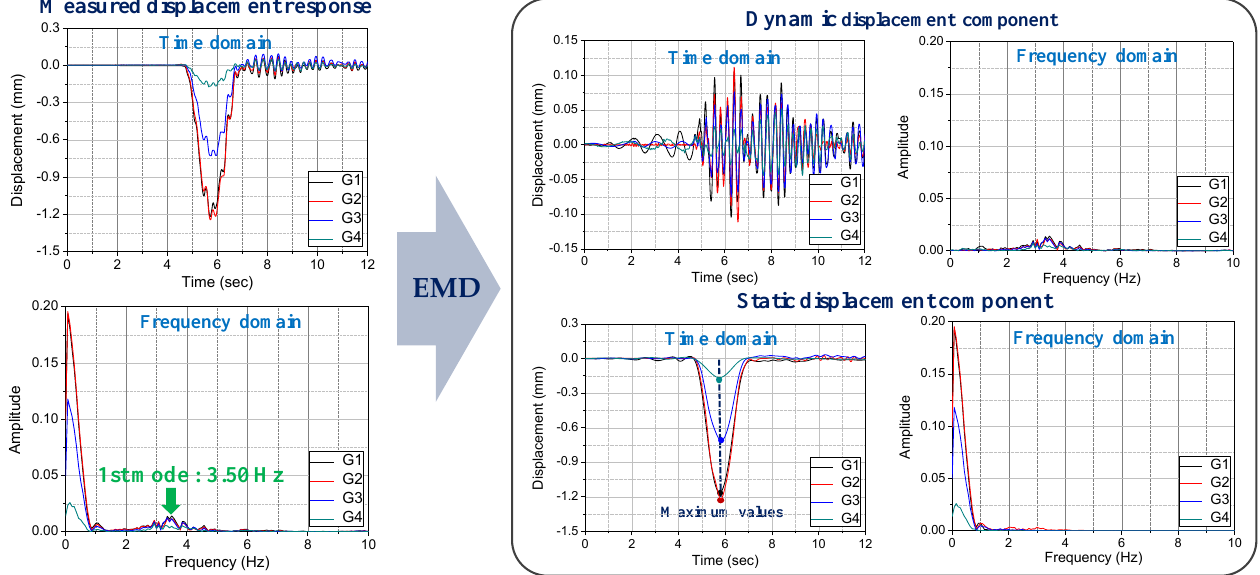
Measured displacement response